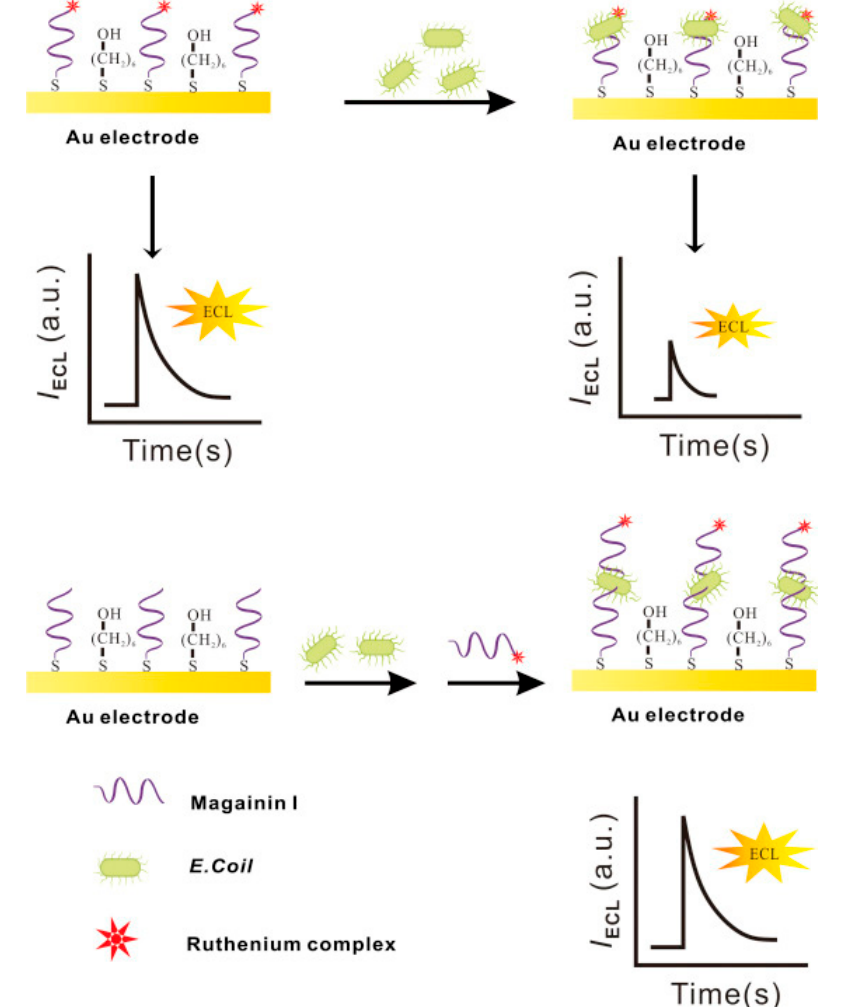
Figure 15. Schematic electrochemiluminescence biosensor fabrication and ECL determination of E. coli O157:H7 [133]. Copyright 2015,